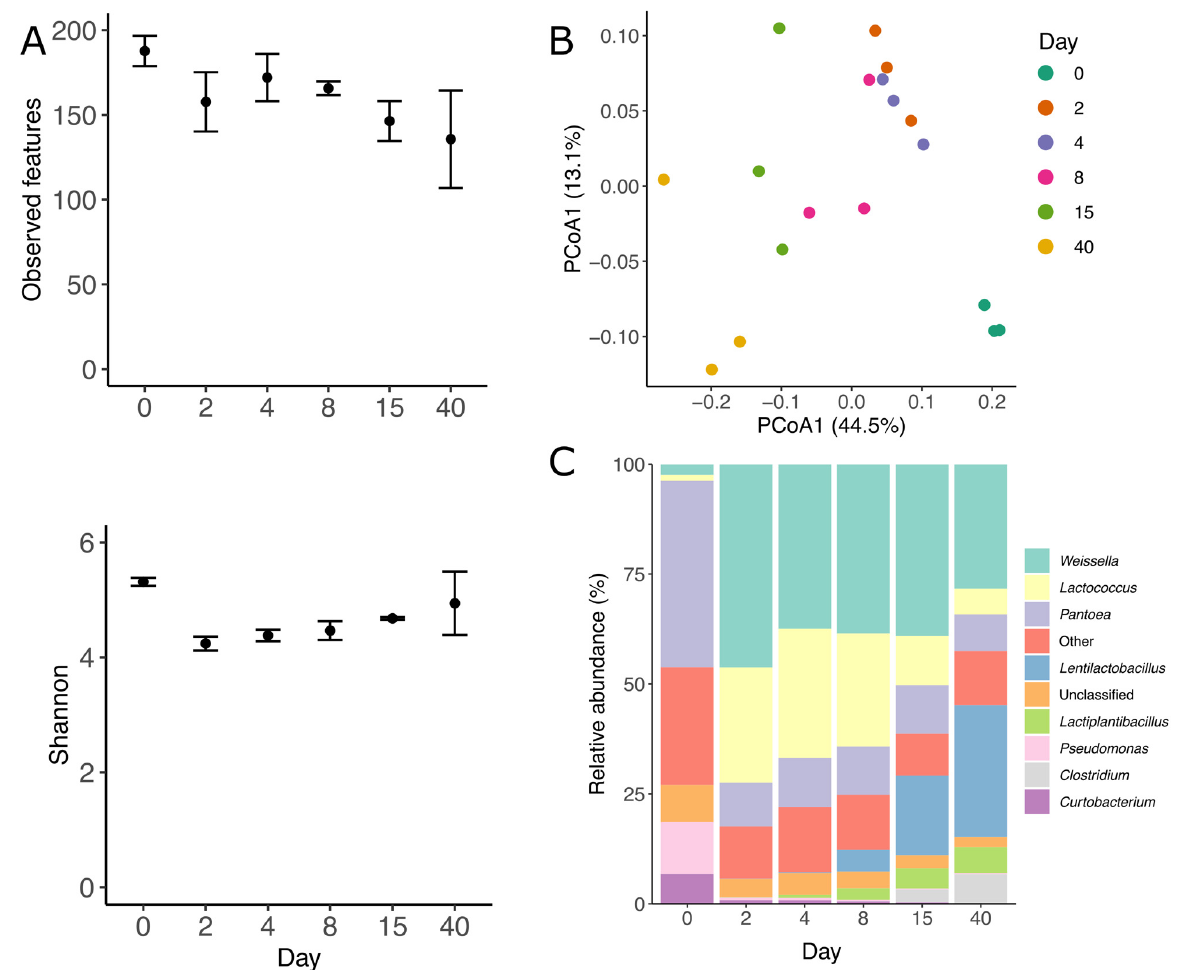
Figure 2. Bacterial diversity and abundance during grass ensilaging based on 16s rRNA amplicons. ( A ) Observed features (ASVs) and Shannon diversity, ( B ) ordination plot (PCoA) of bacterial ASVs based on unweighted UniFrac distances. Each circle represents a sample, and the color represents the time the sample was taken. The closer the circles, the more similar the bacterial communities are. The number between parenthesis indicates the variance explain in each axis. ( C ) Bacterial taxonomy at the genus level across 40 days of ensilaging. Others represent all genus < 5% abundant.